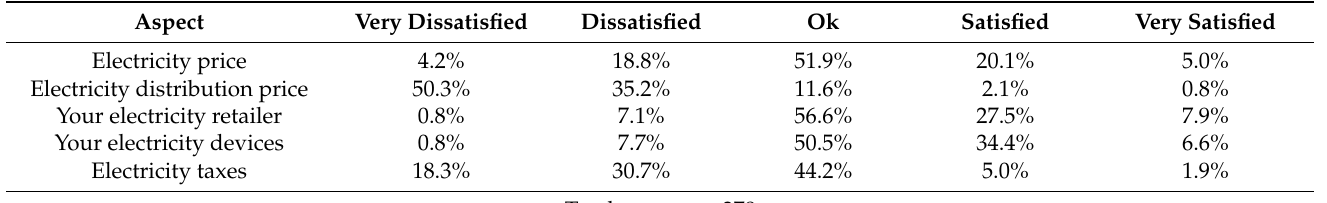
Table A3. The satisfaction of respondents on electricity related aspects.